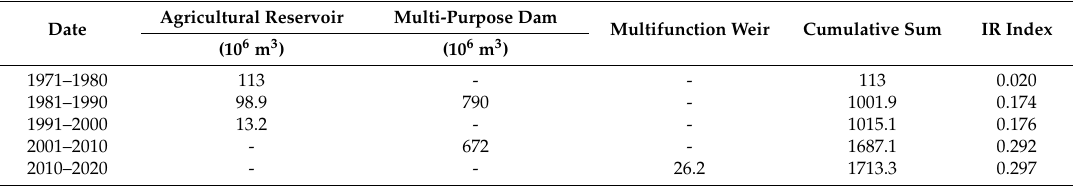
Table 5. Storage capacity of cumulative total of reservoirs and IR